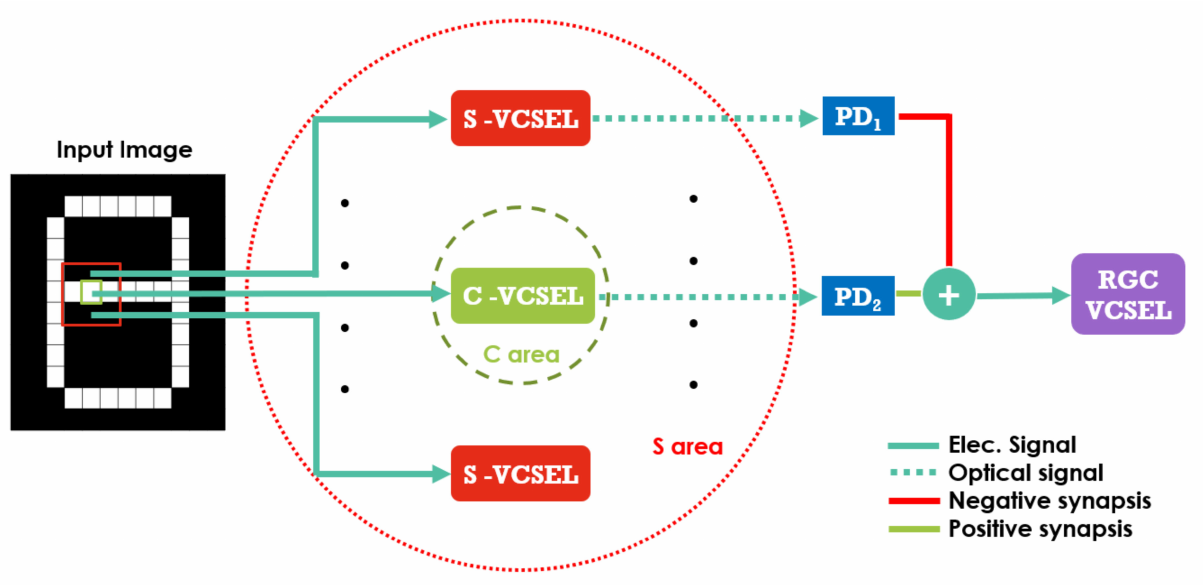
Figure 3. VCSEL based retina ganglion cell (RGC) calculating the contrast of a specific pixel (green box). Each VCSEL takes input from a specific pixel of the SW (red box). Depending on that input, the first 9 VCSEL-neurons, which realize the receptive field of the human eye, produce spikes or remain stable. The outputs of C and S VCSELs are integrated by two photodiodes (PD) whose outputs are weighted and summed before they are injected into the RGC VCSEL. The C-VCSEL (green) has an excitatory effect (positive weight) on the RGC-VCSEL while the outputs of the S-VCSELs (red) have an inhibitory effect (negative weight). The RGC-VCSEL produces a spike for each pixel and according to the spatial distribution of the black and white pixels the spike latency is increased or